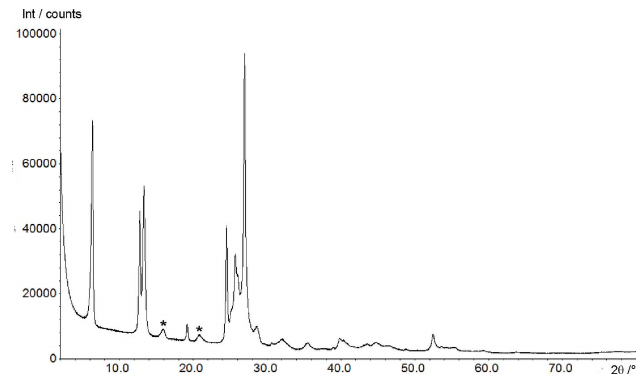
Figure 2 X-ray powder pattern of DFQ, measured with Cu K (cid:8) 1 radiation. The stars denote two single-indexed broad reflections. For discussion see Section